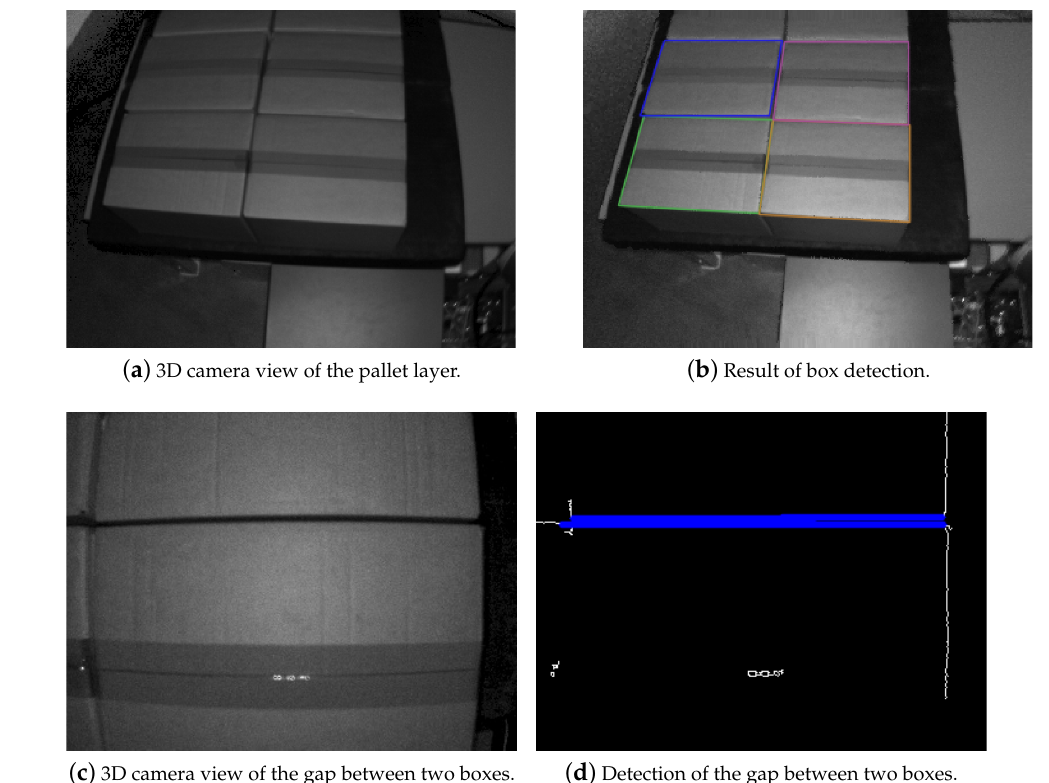
Figure 6. Detection of parcel boxes and their separation